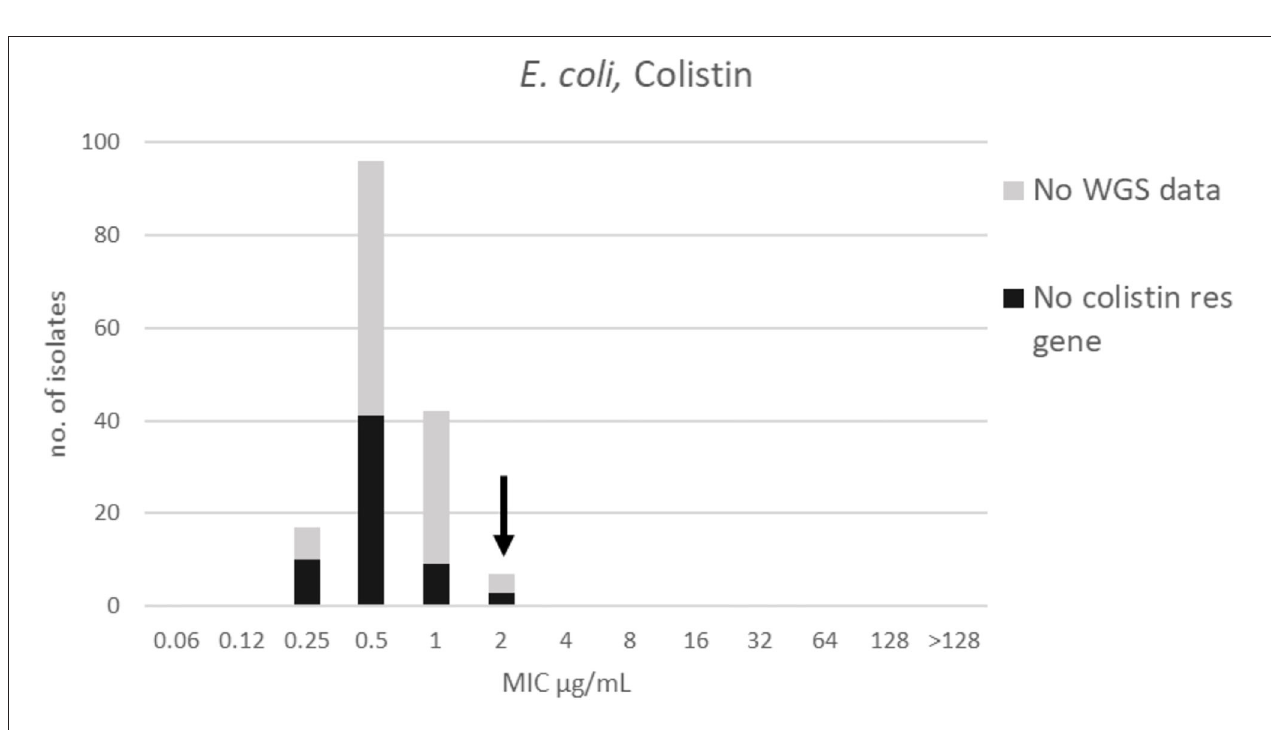
Table 2 . No colistin resistance genes were detected in any of the sequenced E. coli isolates ( Figure 2